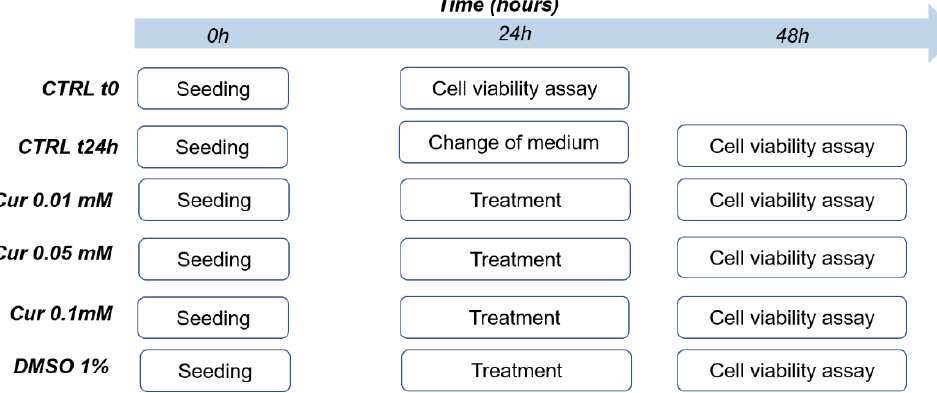
Figure 8. Scheme of the experimental flow used during the cell viability